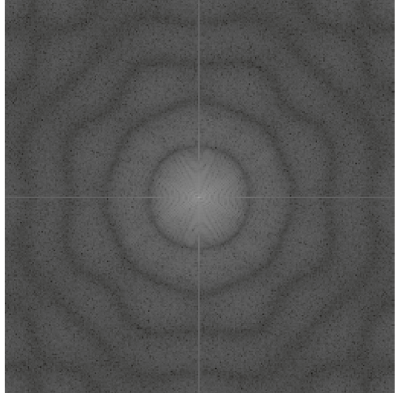
Figure 10: Grayscale PSD estimate.